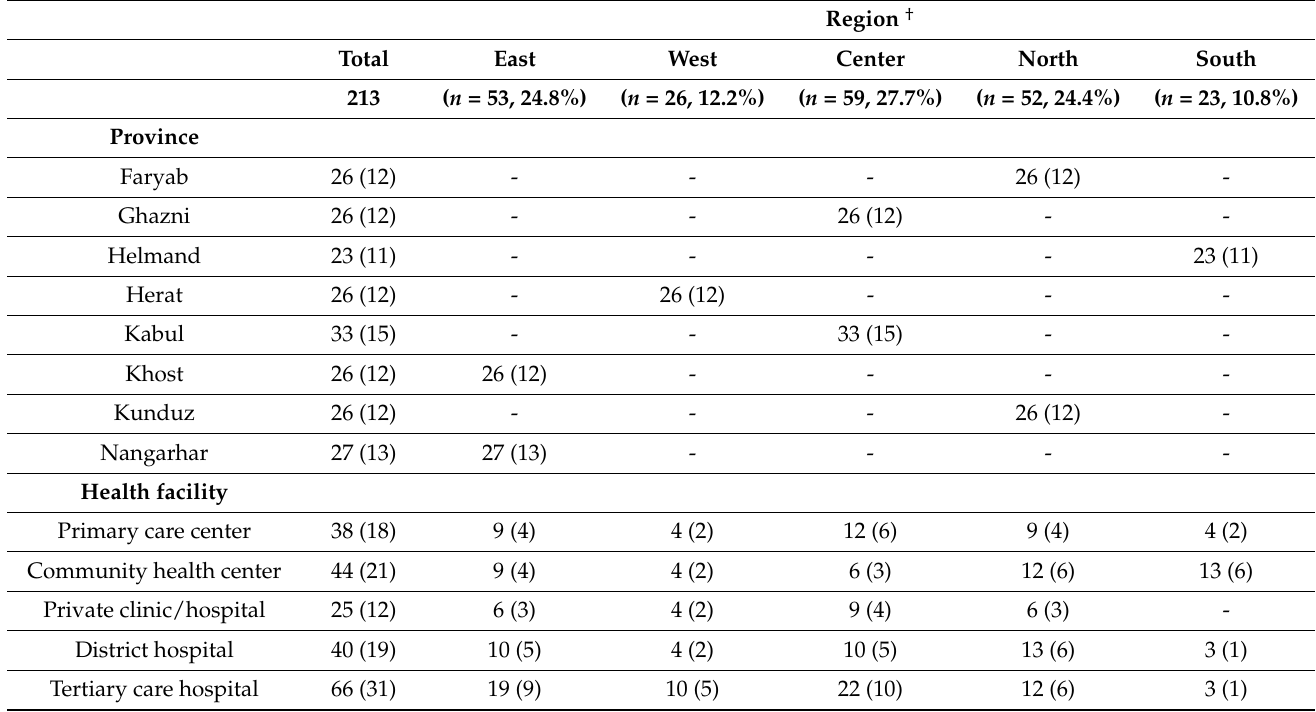
Table 1. Sociodemographic characteristics of healthcare workers surveyed on COVID-19 in